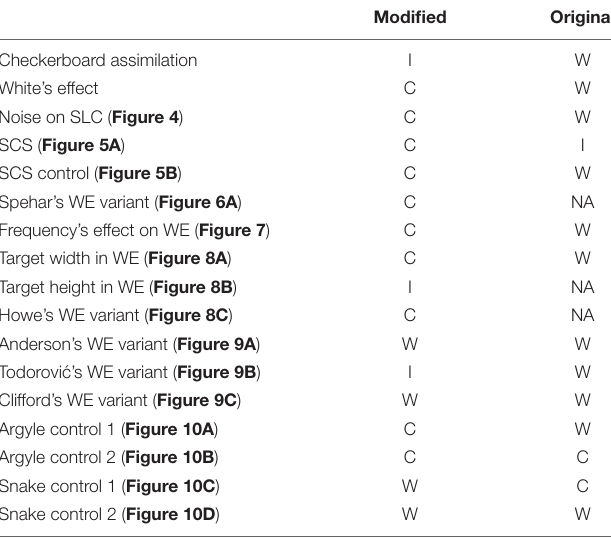
TABLE 2 | Summary of the model tests performed in this study.